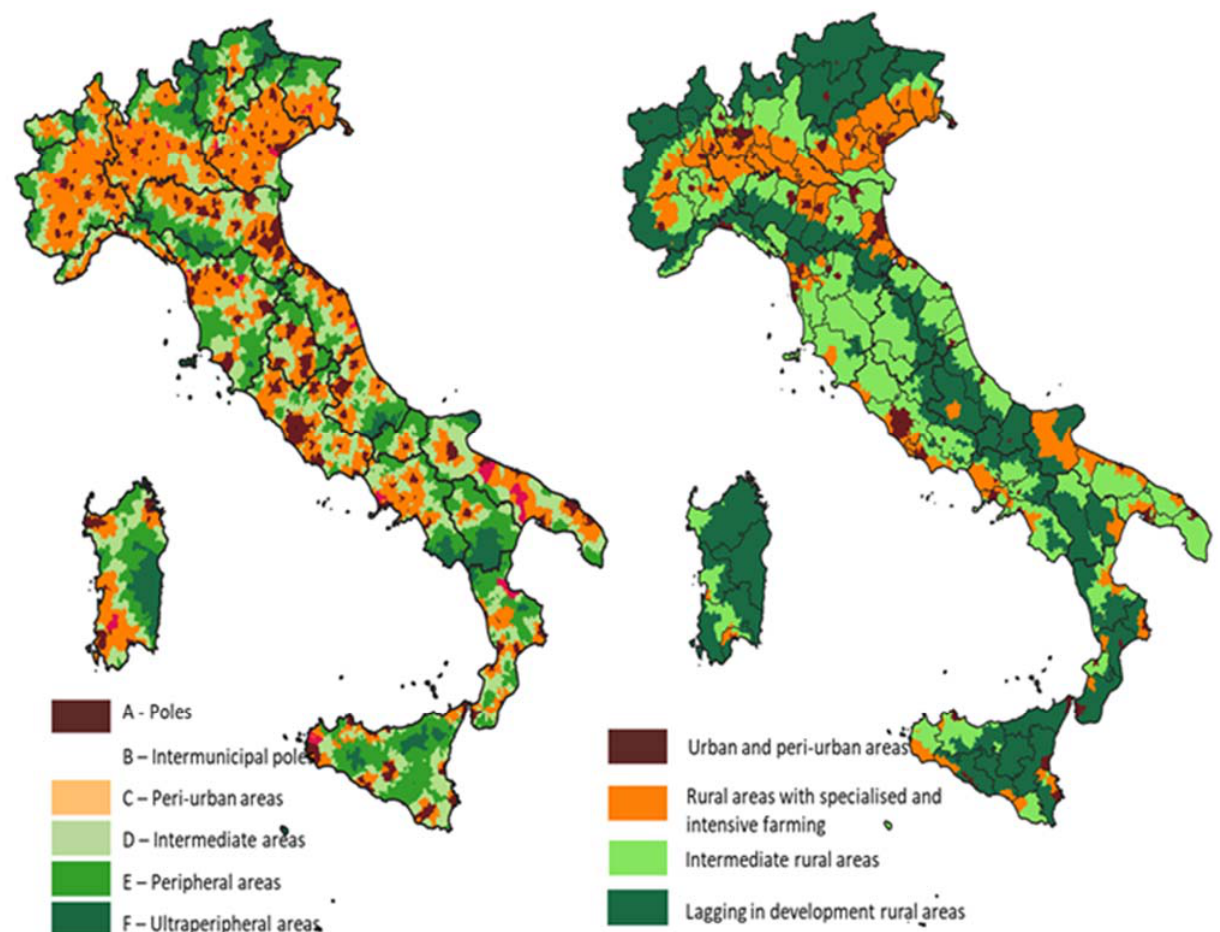
Figure 1. Official definition of rural areas used in Italian programmes of public intervention.